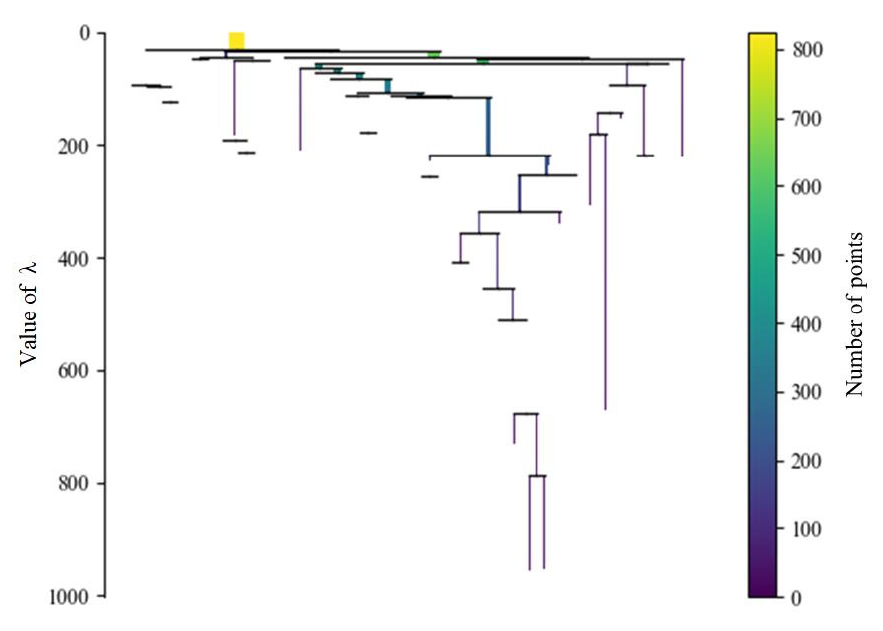
Figure 10. Single-link cluster hierarchy.